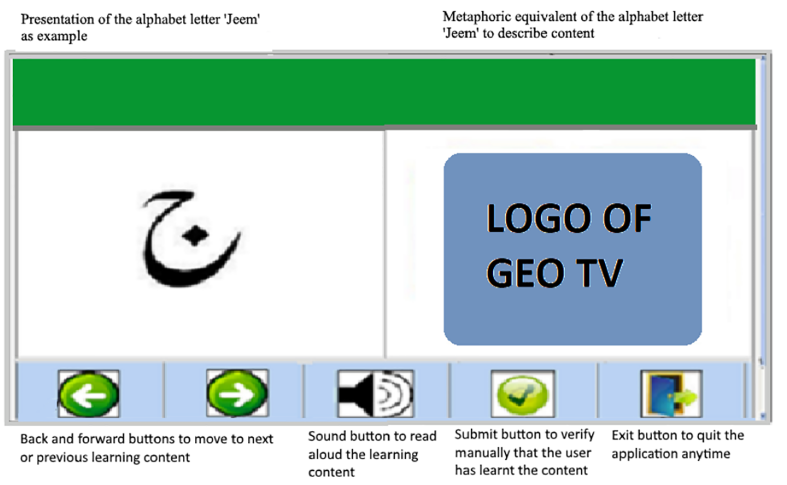
Fig 1. Computer Assisted Learning application presenting the EPM-based learning content (ELC). The traditional content was presented without displaying the EPM content.